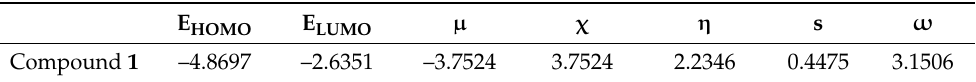
Table 2. Global reactivity descriptors (in eV) of Compound 1 at the B3LYP/Def2SVP-LANL2DZ level of theory using the ECP = LANL2DZ for V and Cu atoms in the PCM